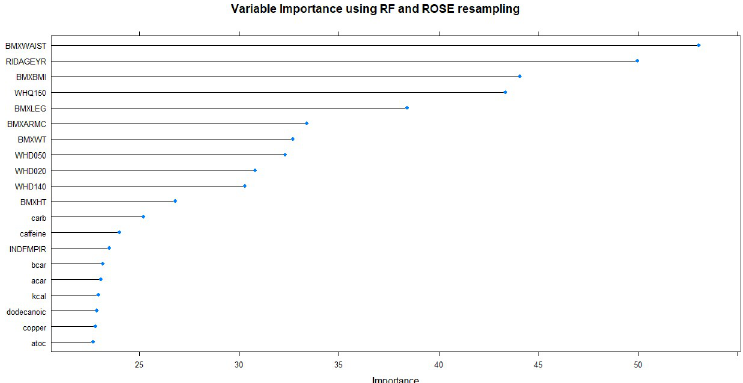
Fig 8. Variable importance plot of the best-performing random forest model produced by ROSE resampling. BMXWAIST = waist circumference; RIDAGEYR = age; BMXBMI = body mass index; WHQ150 = age when heaviest weight; BMXLEG = upper leg length; BMXARMC = arm circumference; BMXWT = weight; WHD050 = self-reported weight– 1 year ago; WHD020 = current self-reported weight; WHD140 = self-reported greatest weight; BMXHT = standing height; carb = carbohydrate; caffeine = caffeine; INDFMPIR = income-poverty ratio; bcar = beta carotene; acar = alpha carotene; kcal = energy; dodecanoic = SFA 12:0 (Dodecanoic); copper = copper; atoc = vitamin E alpha tocopherol.